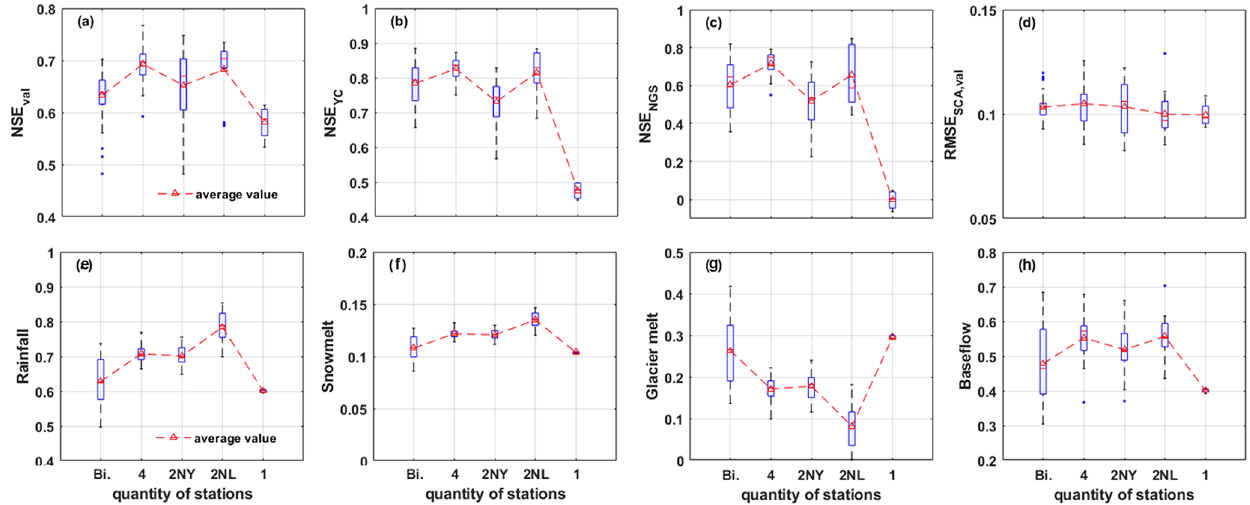
Figure 8. Model performances (a–d) and runoff component contributions (e–h) in the YTR basin in different scenarios using precipitation isotope measurements from different sampling sites (Experiment 2). Subplot (a) and (d) are the performances for Nuxia streamflow and SCA simulation in the validation period, respectively. Subplot (b) and (c) are the performances for streamflow simulation at internal stations Yangcun and Nugesha, respectively. Subplot (e) – (g) are the contribution of runoff components based on water source definition. Subplot (h) is the contribution of baseflow based on the runoff pathway